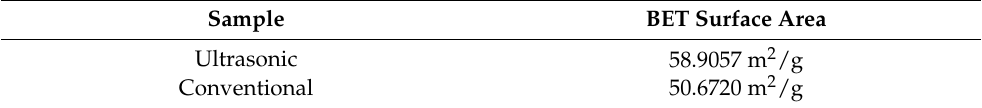
Table 3. Specific surface area of leached slag under conventional and ultrasonic conditions.